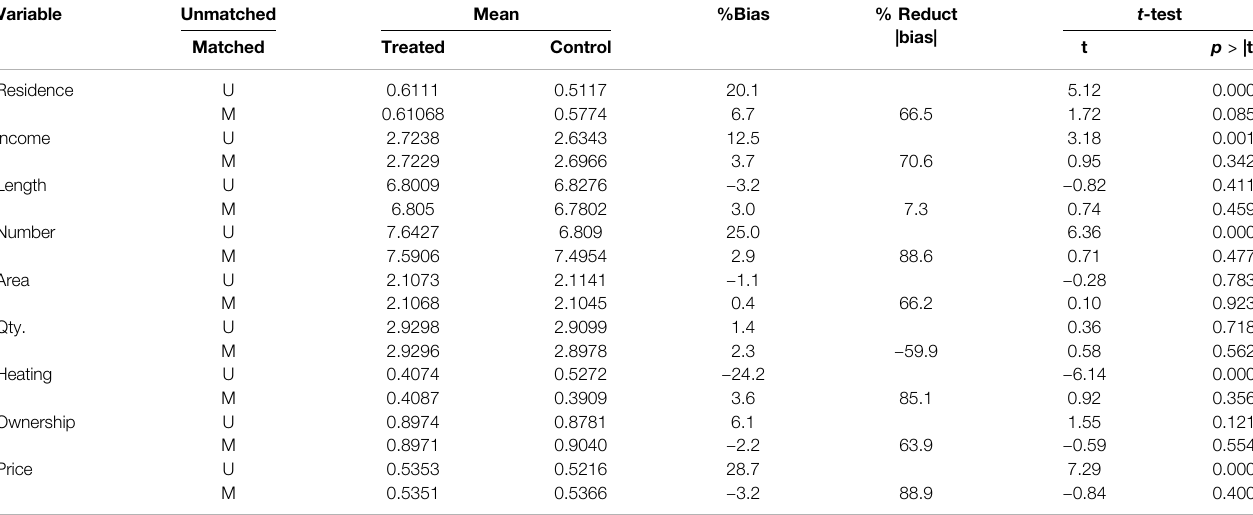
TABLE 6 | Test of equality of means of each variable before and after matching for smart meters. Variable Unmatched